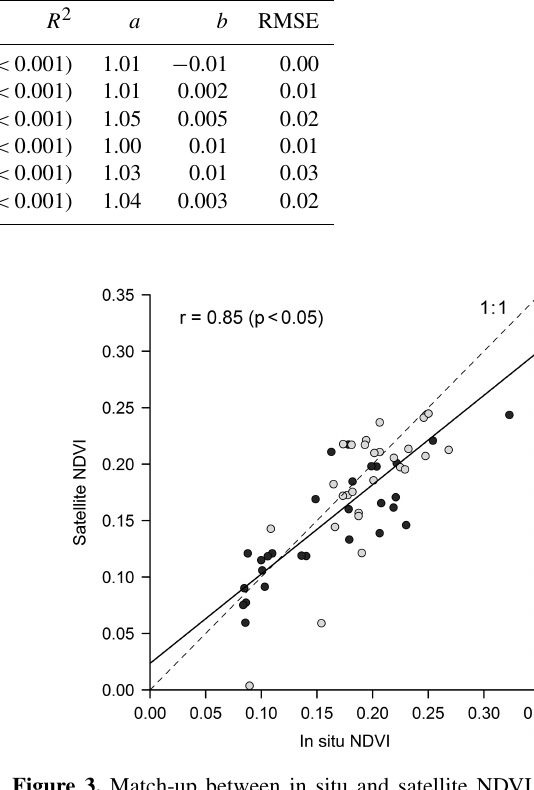
Figure 3. Match-up between in situ and satellite NDVI (see Ta- ble 2). Black dots were sampled on the experimental site, while grey dots were sampled on the additional site of La Coupelasse. Pearson correlation coefficient was calculated. The slope of the lin- ear regression model applied to the data (black linear regression line, RMSE = 0.04, n = 57) was not significantly different from 1 ( a = 0 . 79, p = 0 .